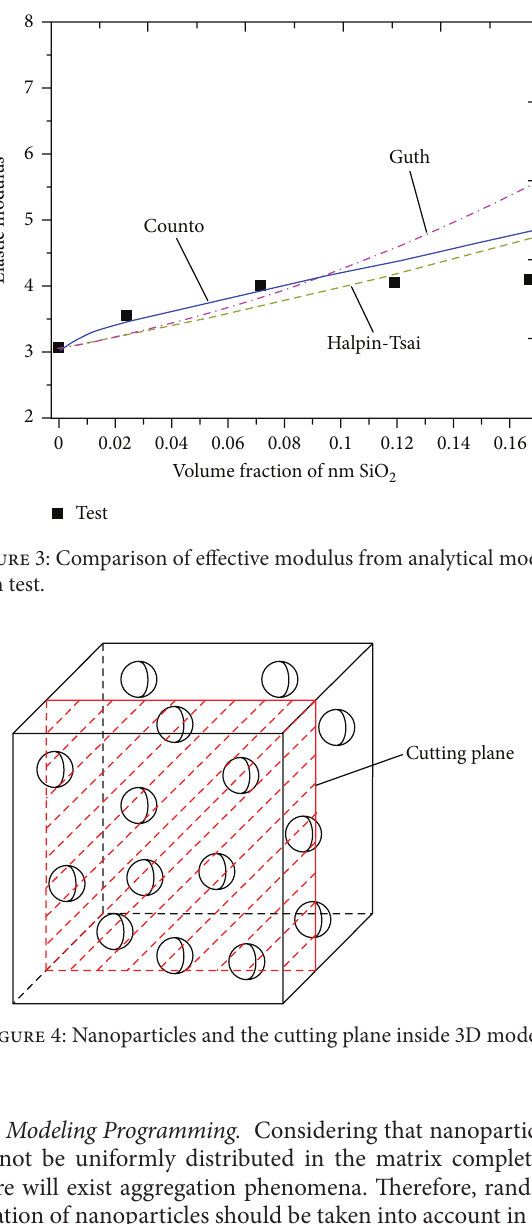
Figure 4: Nanoparticles and the cutting plane inside 3D